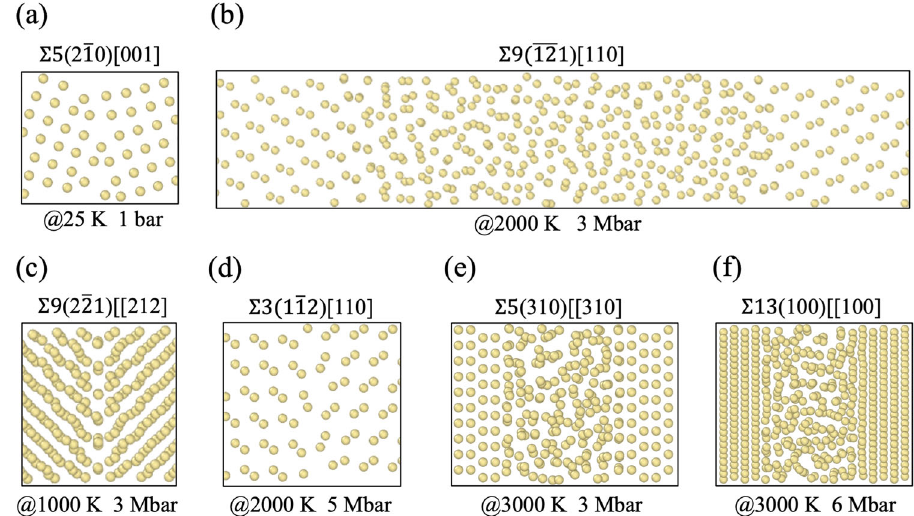
Fig. 1 Examples of grain boundaries used in this work. a , c , and d contain crystalline – crystalline boundaries, while b , e , and f contain two crystalline – amorphous boundaries.